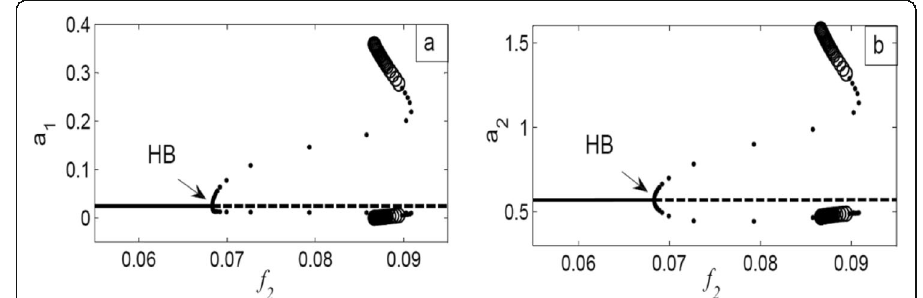
Fig. 8 Bifurcation diagram of f 2 as the bifurcation parameter. Stable steady state branch, thick black line; unstable steady state branch, thick broken black lines; stable periodic branch, black circles; unstable periodic branch, hollowed/white